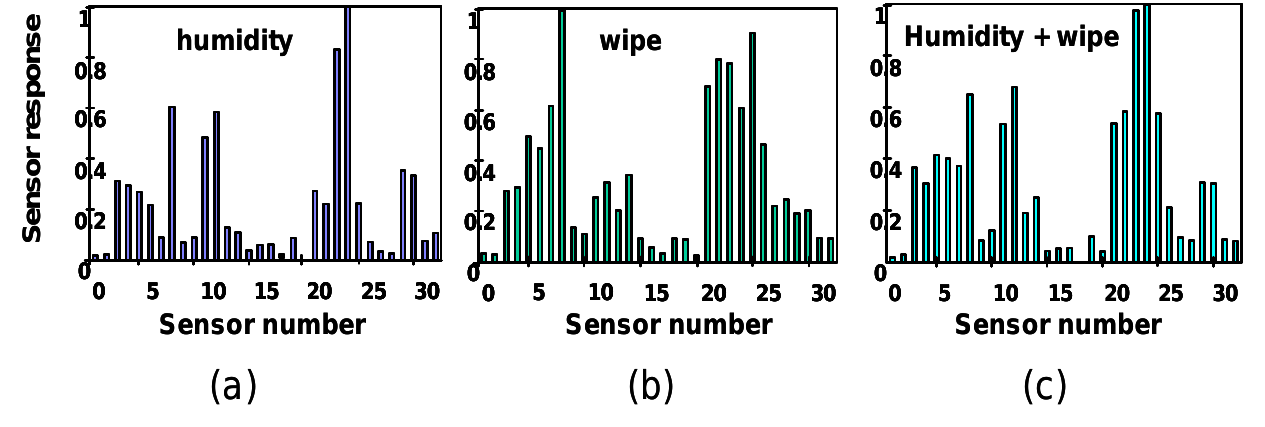
Figure 4 . (a) A typical fingerprint of humidity change event identified from the flight data, which corresponds well with the normalized pattern recorded in ground testing (see fig.1). (b) A